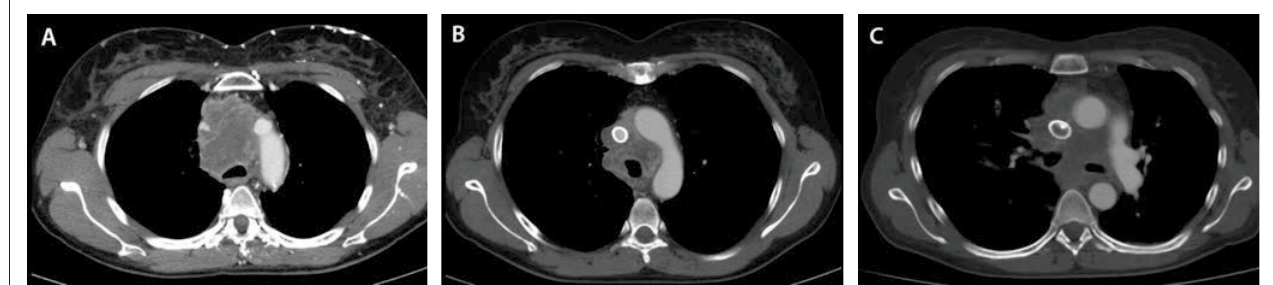
Fig. 4. (A) A central, small cell lung cancer in the upper mediastinum with encasement of mediastinal structures, in particular the superior vena cava. In the area of the chest wall, especially on the left side, an increased venous drawing is visible at skin level. (B) Follow-up computed tomography (at 3 months) after stent implantation. The stent in the superior vena cava is in the correct position and the vascular lumen is free perfused. (C) Follow-up computed tomography (at 6 months) after stent implantation. Restenosis of the superior vena cava by progression of tumour growth, in particular through the stent mesh. A planned re-intervention was not performed because the patient died from the consequences of the